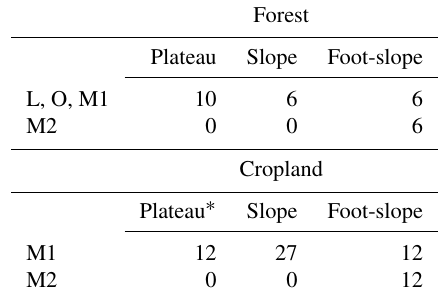
Table 2. Numbers of samples taken at three forest (DR Congo, Uganda, Rwanda) and two cropland (DR Congo, Uganda) study sites. While the O-horizon depth is measured individually for each sample, the L-horizon depth is assumed to be 1cm as it was not possible to be accurately measured. L: L horizon; O: O horizon; M: mineral layers 1: 0–60cm and 2: 60–120cm in forest and 60– 100cm in cropland. Forest Plateau Slope Foot-slope L, O,